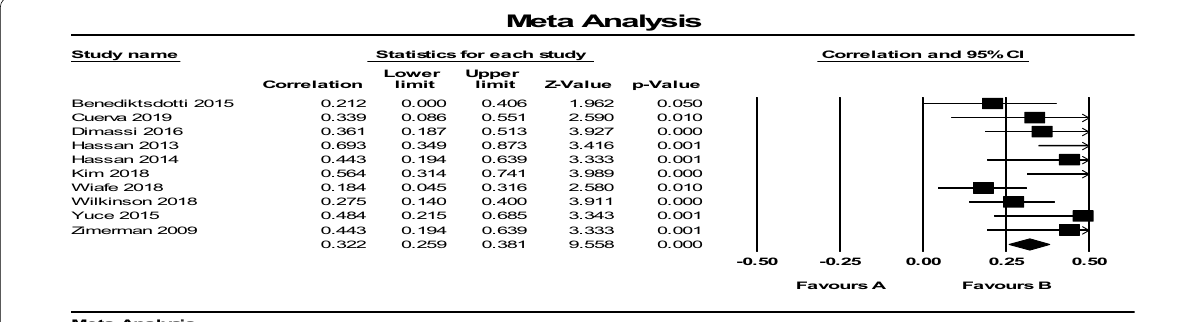
(Fig. 4). The limits of agreement were 0.258–0.434. The I 2